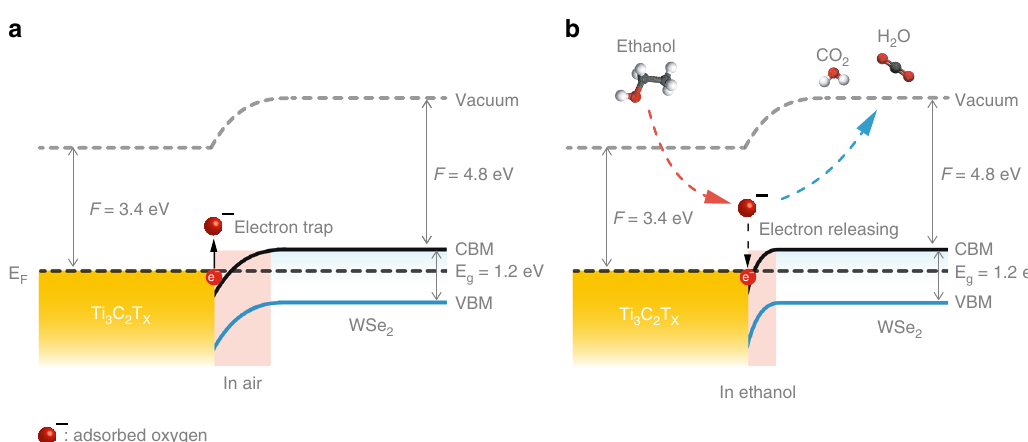
Fig. 7 Enhanced sensing mechanism of Ti 3 C 2 T x /WSe 2 heterostructure. Energy-band diagram of the Ti 3 C 2 T x /WSe 2 in a air and b ethanol, showing the variation of the depletion layer with interaction between adsorbed oxygen species and ethanol